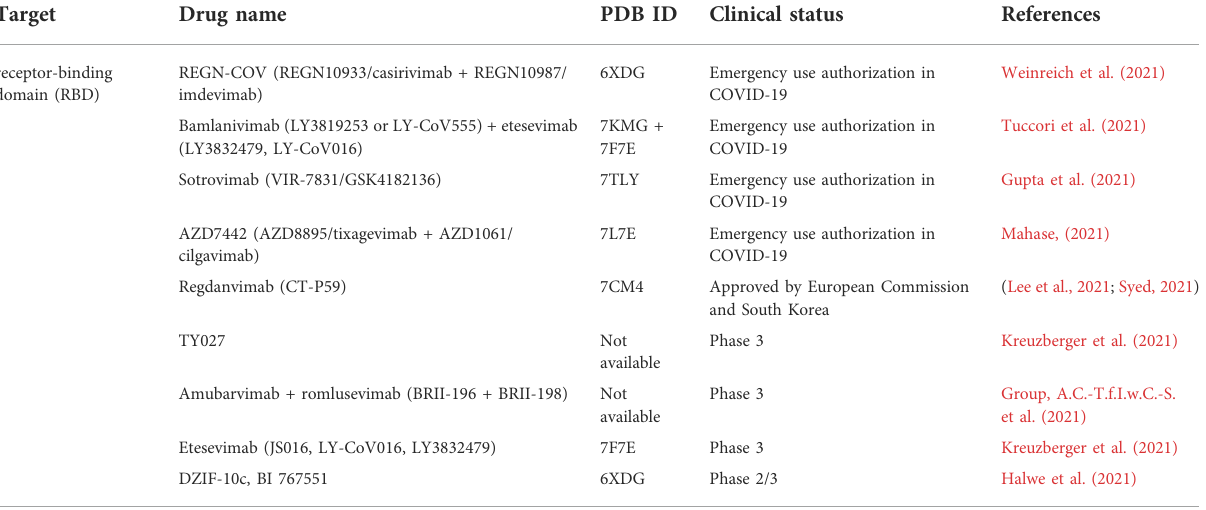
TABLE 2 Antibody treatments for COVID-19 at or after phase three clinical trial.